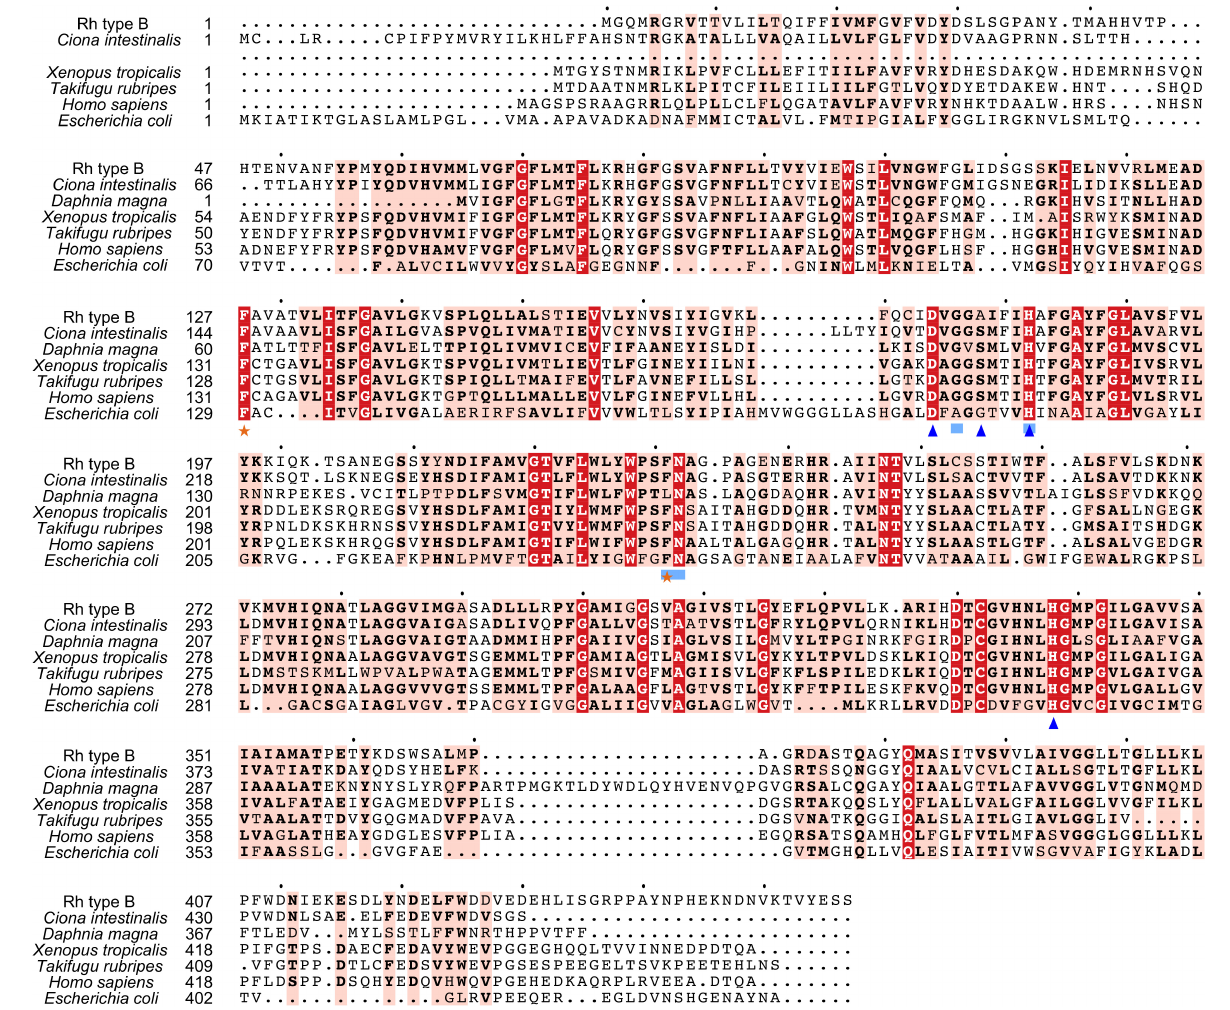
FIGURE 4 | Multiple amino acid alignment of deduced Rh type B of M. manhattensis with E. coli AmtB and corresponding sequences of selected species. Identical amino acid residues are in bold white and filled with red. Strongly similar amino acid residues are in bold black and filled with light red. Phenylalanine gates of the ammonia channel are indicated by black stars. Residues involved in NH 4 + recruitment are indicated by light blue strokes. Residues involved in deprotonation are indicated by blue